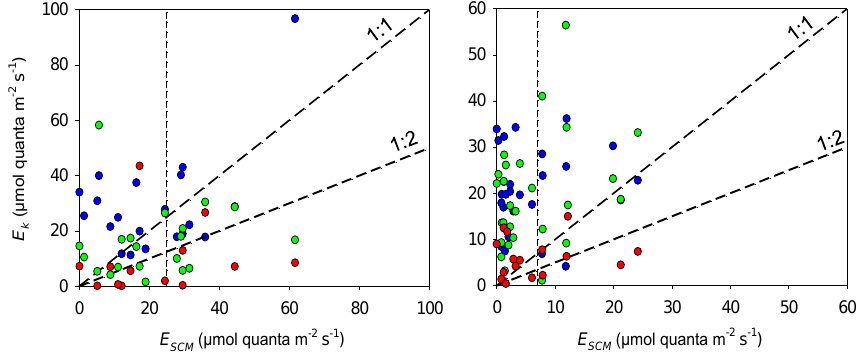
(green circles) and NH + (red circles) 3 4